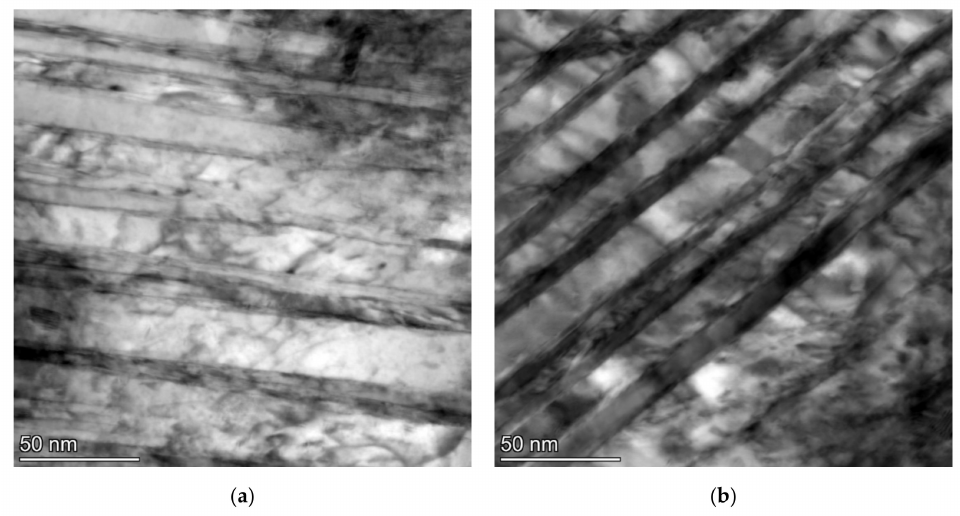
Figure 7. TEM micrographs of the sample after SAT350 processing, showing the interior of the bright island in martensite ( a ) and the lath with tempering carbides ( b ).